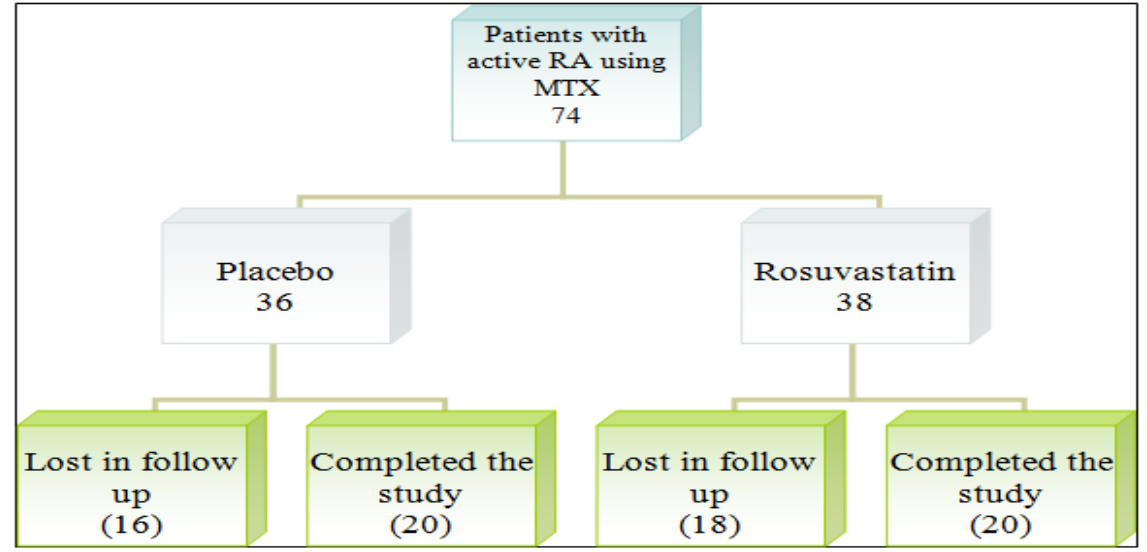
Figure 1: Schematic presentation for patient participating in the